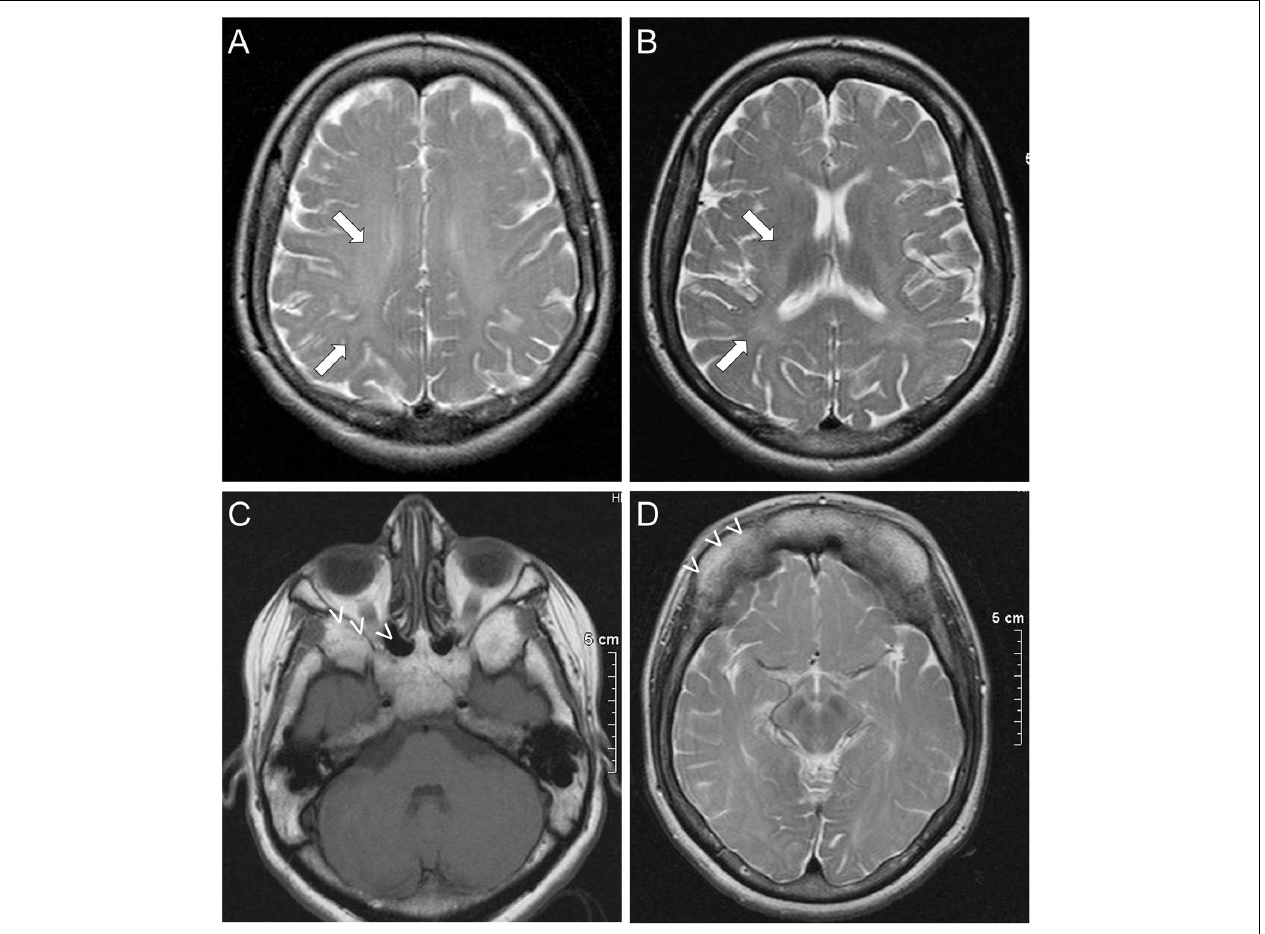
FIGURE 1 | Imaging features of ODDD: Brain MRI of patient II shows subtle findings of leukodystrophy, with delayed myelination in the white matter (arrows) most prominently of the frontal and parietal lobes in the centrum semiovale (A) and toward the internal capsules (B) . Dysmorphic features of ODDD including hypoplasia of the nasal and maxillary sinuses with small orbits (C) and complete aplasia of the frontal sinuses (D) are also demonstrated (open arrowheads).